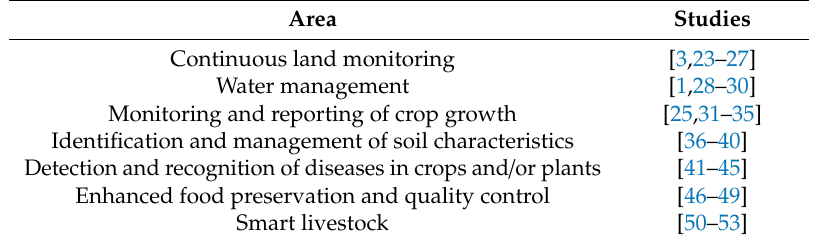
Table 1. Overview of Internet of Things (IoT) usage and integration areas and corresponding